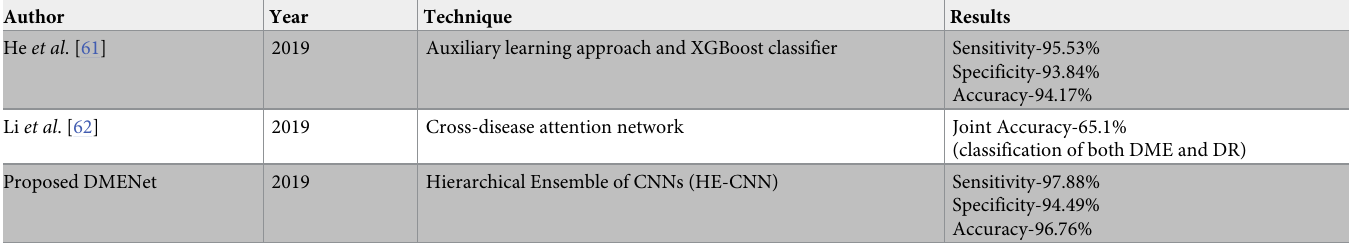
Table 6. Comparitive study of DMENet’s performance with recent solutions for DME screening using IDRiD